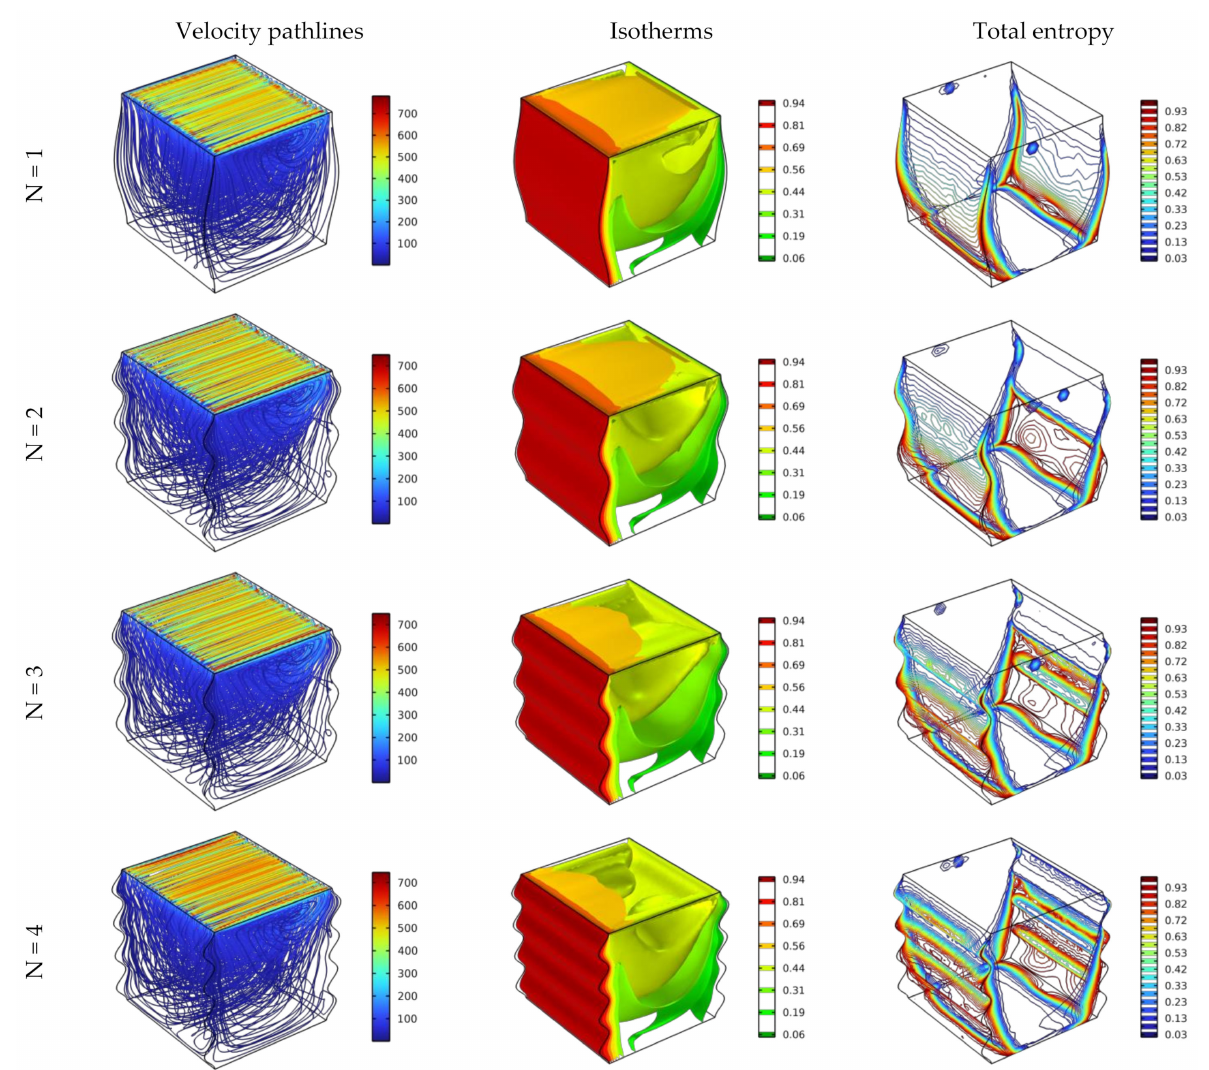
Figure 5. Distribution of streamlines, isotherm, and total entropy for Ha = 0, Da = 10 − 2 , ϕ = 0.04, and Re =